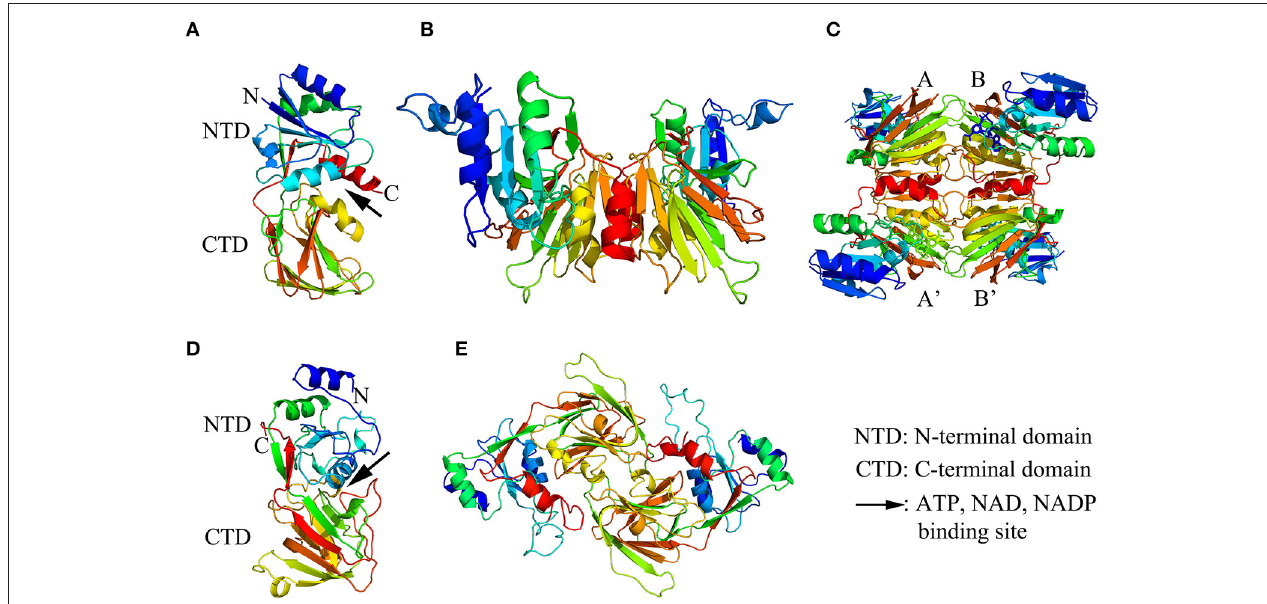
FIGURE 1 | The structure models of NAD kinase. The structure models were constructed using a homology modeling method with the full-length amino acid sequences of a NAD kinase from Archaeoglobus fulgidus (Afnk) and a NADH kinase from Arabidopsis thaliana (AtNADK3). (A–C) showed the ribbon diagram of Afnk monomer, dimer, and tetramer, respectively. The four monomers in the Afnk tetramer were labeled with A, A’, B, and B’ as previously reported (Liu et al., 2005). (D,E) Illustrated the ribbon diagram of AtNADK3 monomer and dimer, respectively. Models were generated in Pymol and colored by rainbow from N terminus to C terminus.